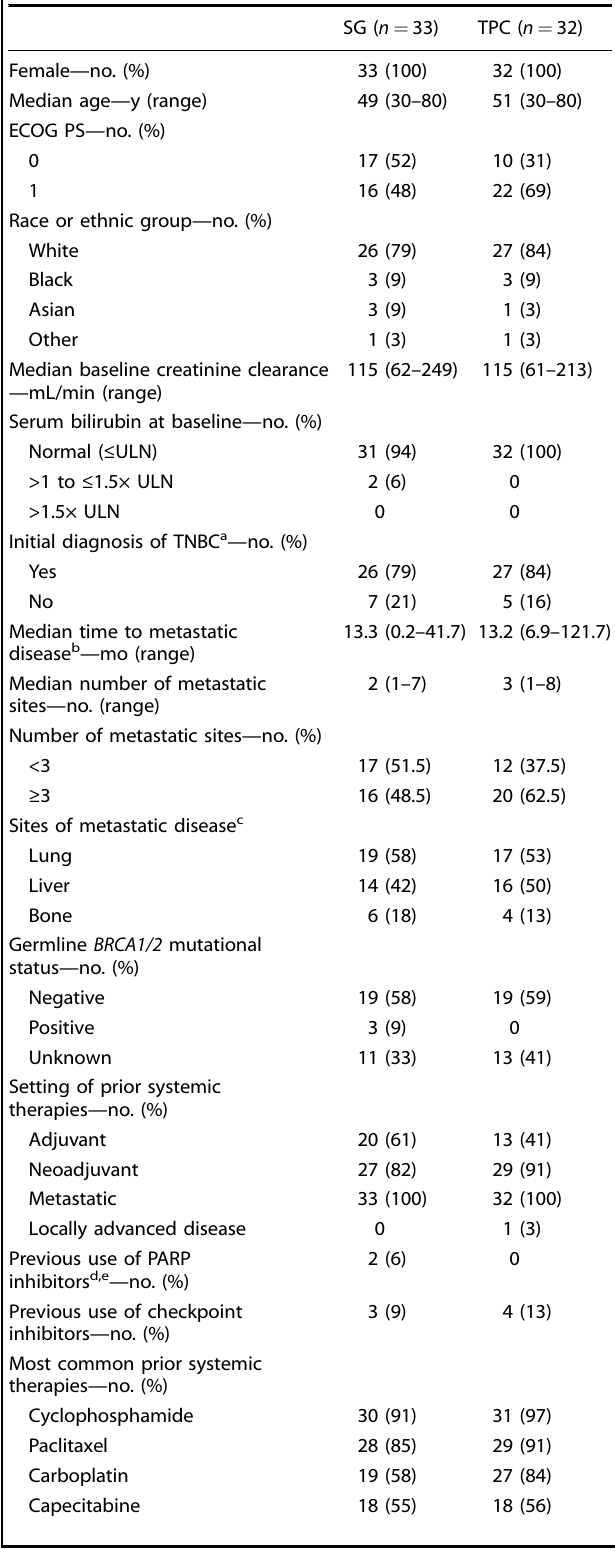
Table 1. Patient demographics and baseline characteristics in the second-line subgroup of patients negative for brain